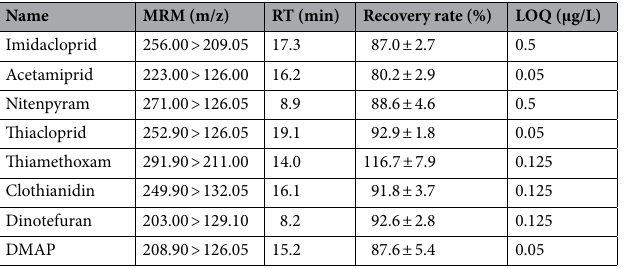
Table 5. The MRM transits, retention times, recovery % and LOQ of seven neonicotinoids and DMAP. MRM multiple reaction monitoring; RT retention time; LOQ limit of quantification; DMAP N -desmethyl acetamiprid.